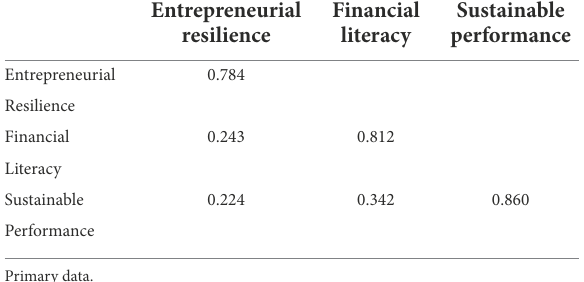
TABLE 2 Discriminant validity (Fornell–Larcker Criteria).